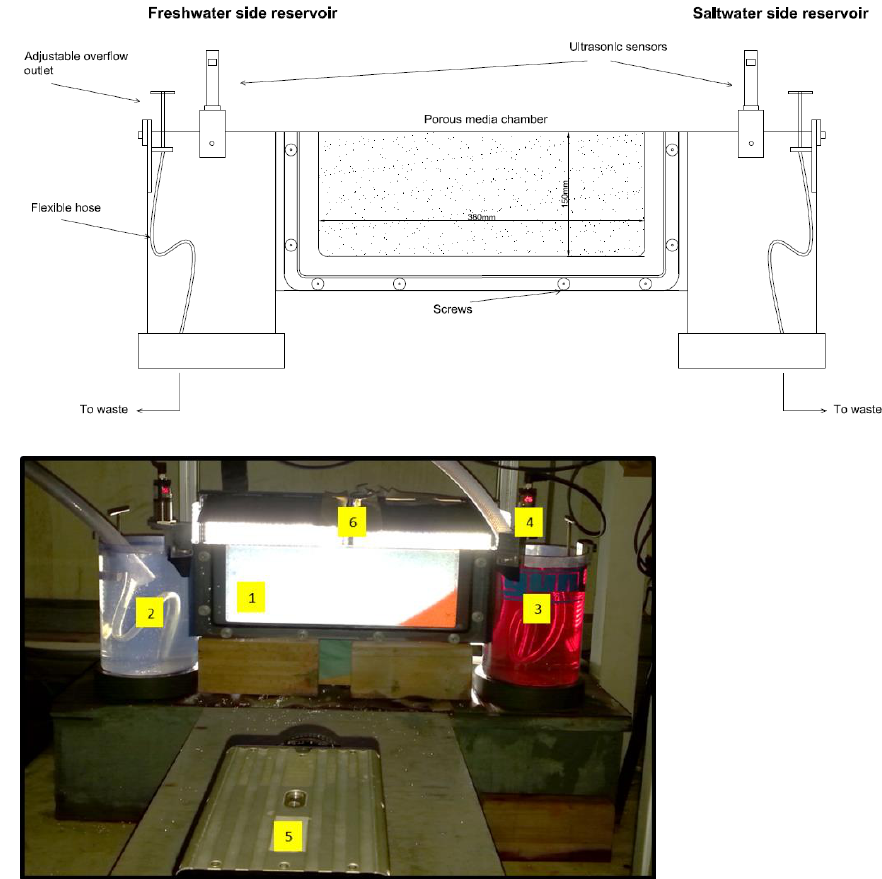
Figure 2. Schematic diagram of the laboratory tank ( top ). Photograph of the experimental setup ( bottom ). (1) Porous media chamber; (2) freshwater reservoir; (3) saltwater reservoir; (4) ultrasonic sensors; (5) high-speed camera; (6) LED lights.